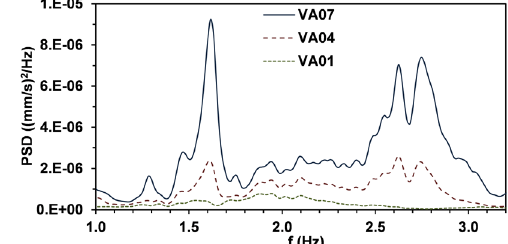
Figure 23. PSDs at Valadier’s buttress in tangential direction.